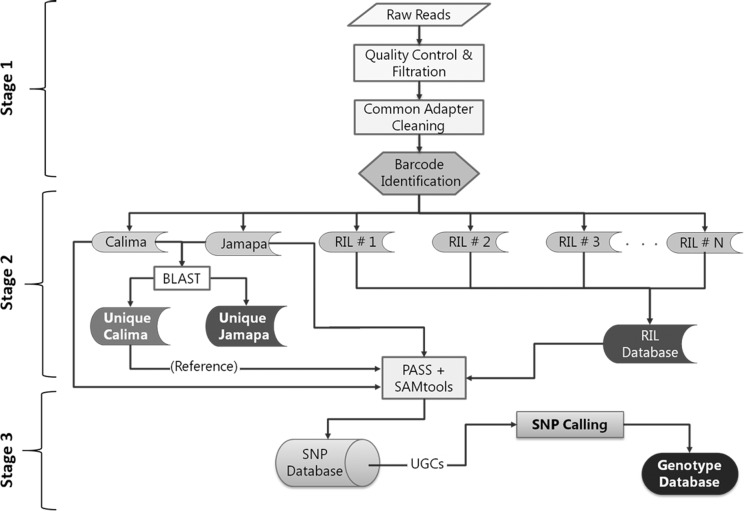
Flow chart illustrating bioinformatics steps used to generate the genotype database for the parental (Calima and Jamapa) and RI lines.Raw sequence data obtained through genotyping-by-sequencing approach was processed in three stages. Stage 1 represent filtration steps and quality check of raw data. Stage 2 depicts separation of sequenced reads using barcode and generation of reference reads set. Stage 3 represent the SNP calling and genotype database generation steps.